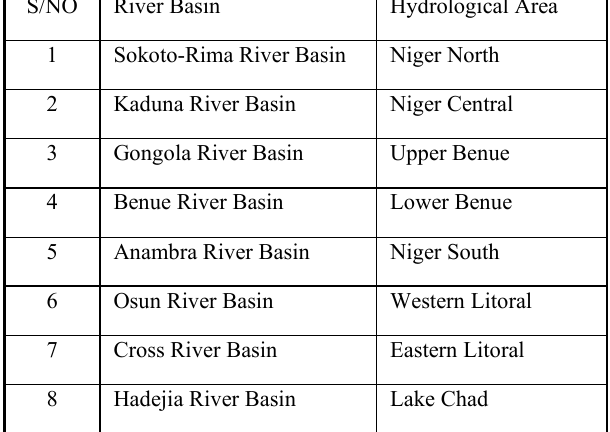
Table 1. River basins and hydrological areas of